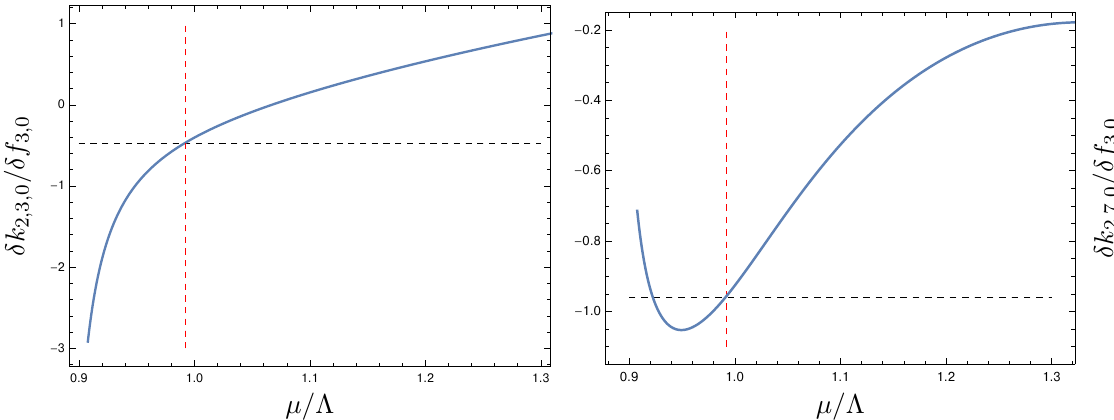
Figure 12 . Parameters δf 3 , 0 , δk 2 , 3 , 0 , δk 2 , 7 , 0 , δf h { s fluctuations over vacua as a function of µ A V scale m = 1, diverge at µ = µ u (5.4), indicated by a vertical red dashed line. µ u identifies the